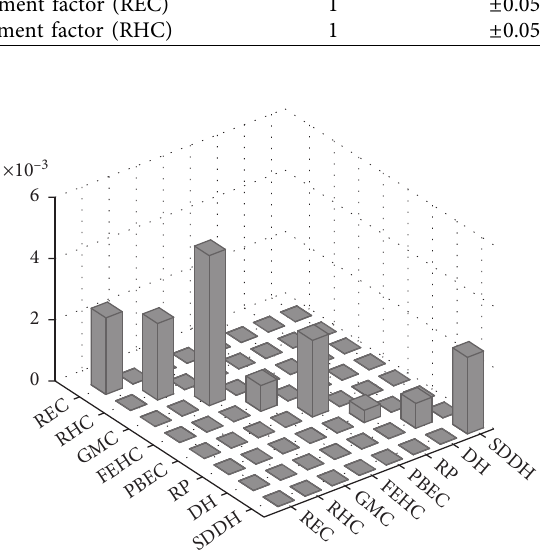
Figure 3: The global relative covariance matrix for the selected eight Table 3: K-S test for the samples of the selected 8 inputs with normal distribution.